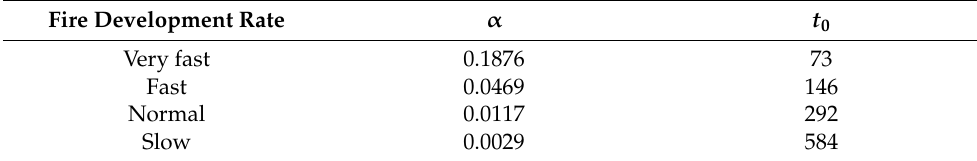
Table 1. Parameters of different